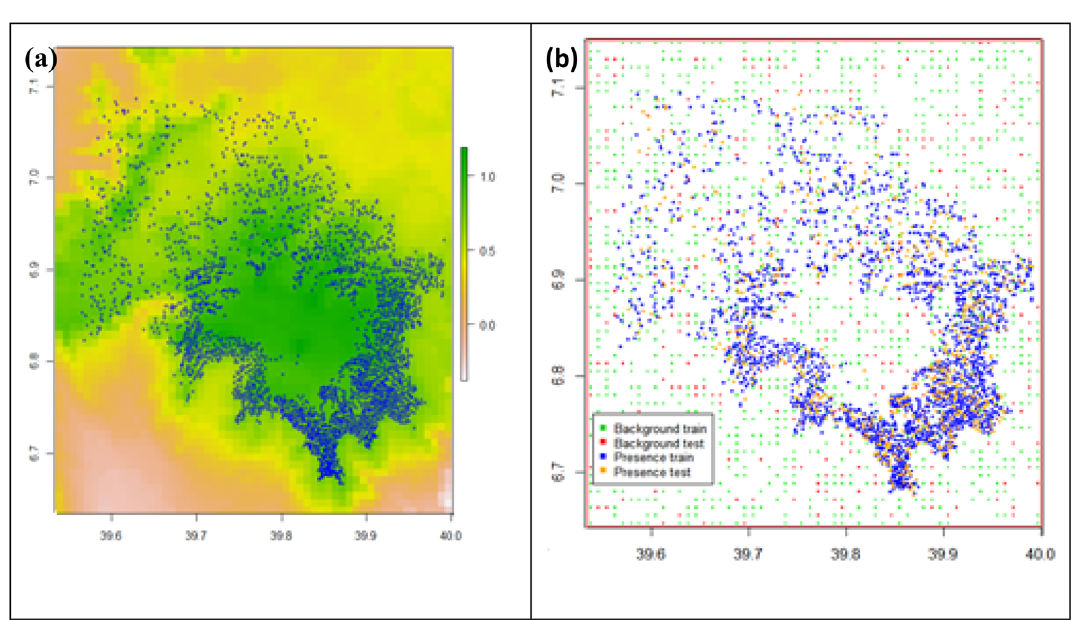
Figure 4. ( a ) Background: Layer stacked environmental predictors variables and sampled Erica (Blue circles) occurrence points, ( b ) Model fitting map with background train (green), background test (red), presence train (blue), and presence test